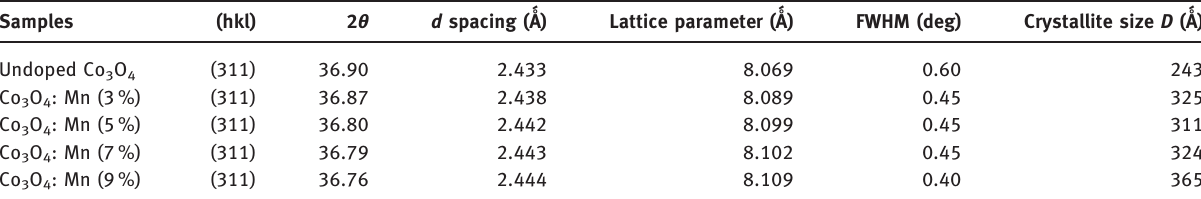
Table 2: Structural parameters of Mn-doped Co 3 O 4 powders.